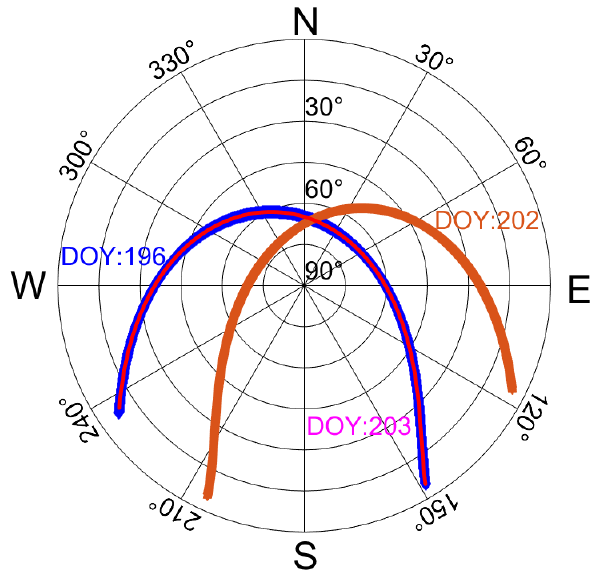
Figure 7. Skyplot of the BDS MEO B20 satellite on DOY:196 (denoted by blue line), DOY:202 (denoted by brown line), and DOY:203 (denoted by pink line), 2021. The vertical means the elevation angle, and the circle represents the azimuth angle.